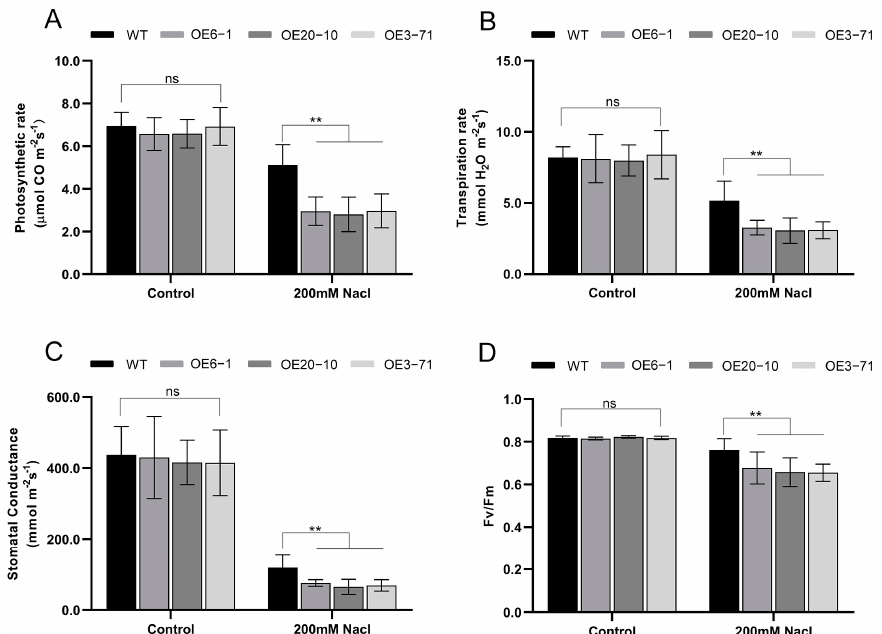
Figure 4. Overexpression of CbWRKY27 reduces photosynthetic performances in transgenic plants under salt treatment. ( A ) Photosynthetic performances of the WT and OE lines with or without salt treatment (200 mM Nacl). Net photosynthetic rate ( µ molCO 2 m − 2 s − 1 ). ( B ) Transpiration rate (mmolH 2 Om − 2 s − 1 ). ( C ) Stomatal conductance (mmolH 2 Om − 2 s − 1 ). ( D ) The maximum efficiency of PSII (Fv/Fm). The data represent the means ± SD ( n = 5), ** p < 0.01 using Student’s t -test.